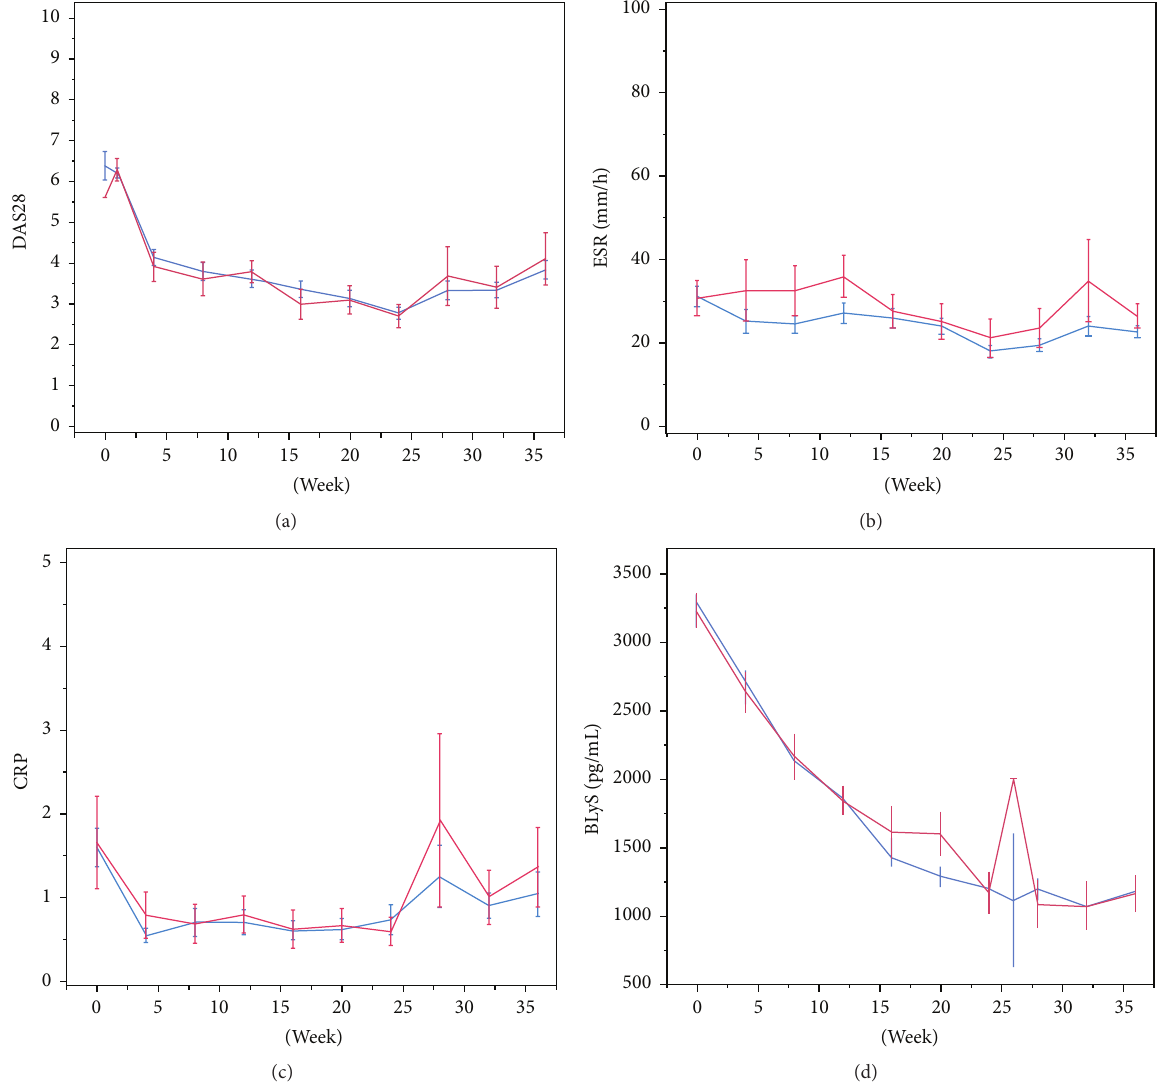
Figure 5: Pharmacodynamic parameters of groups treated with Infinitam (blue) and the reference product (red). (a) DAS28 per visit, (b) ESR per visit, (c) CRP per visit, and (d) BLyS per